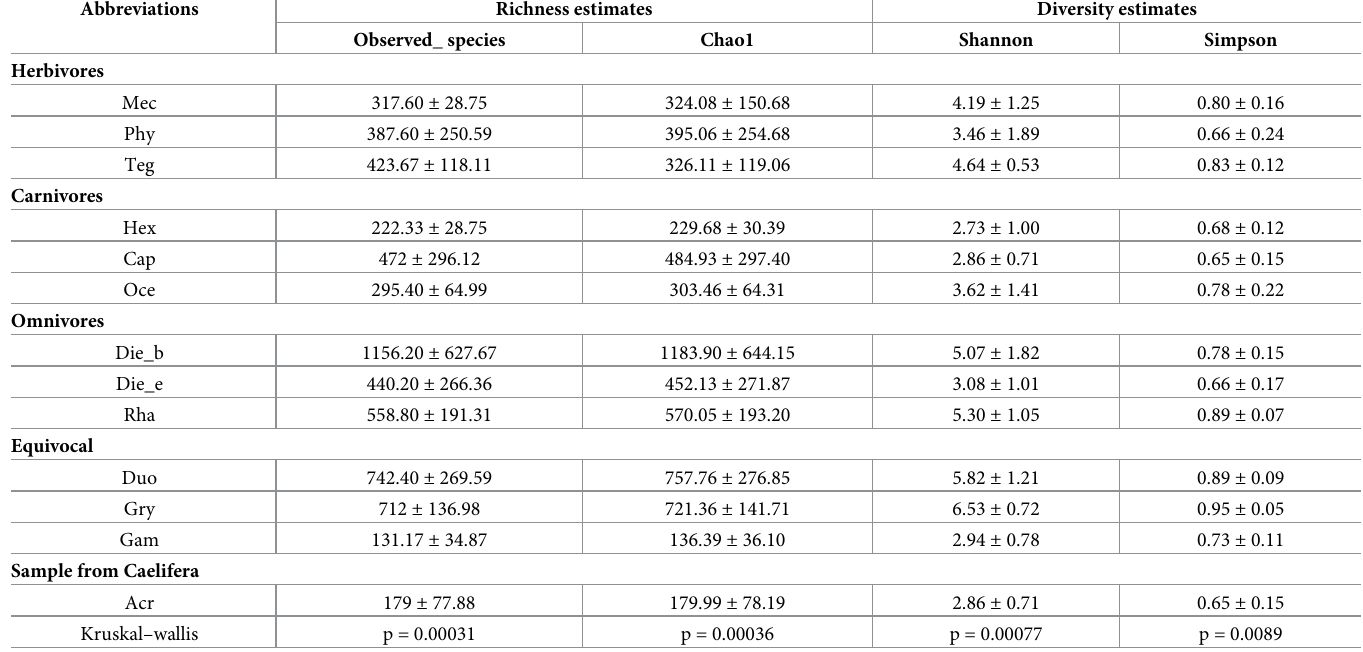
Table 2. Alpha diversity analysis of the gut bacterial communities.